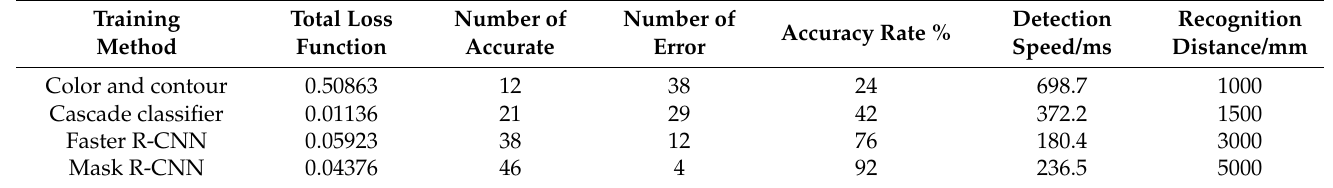
Table 3. Comparison of tennis ball recognition results using different recognition